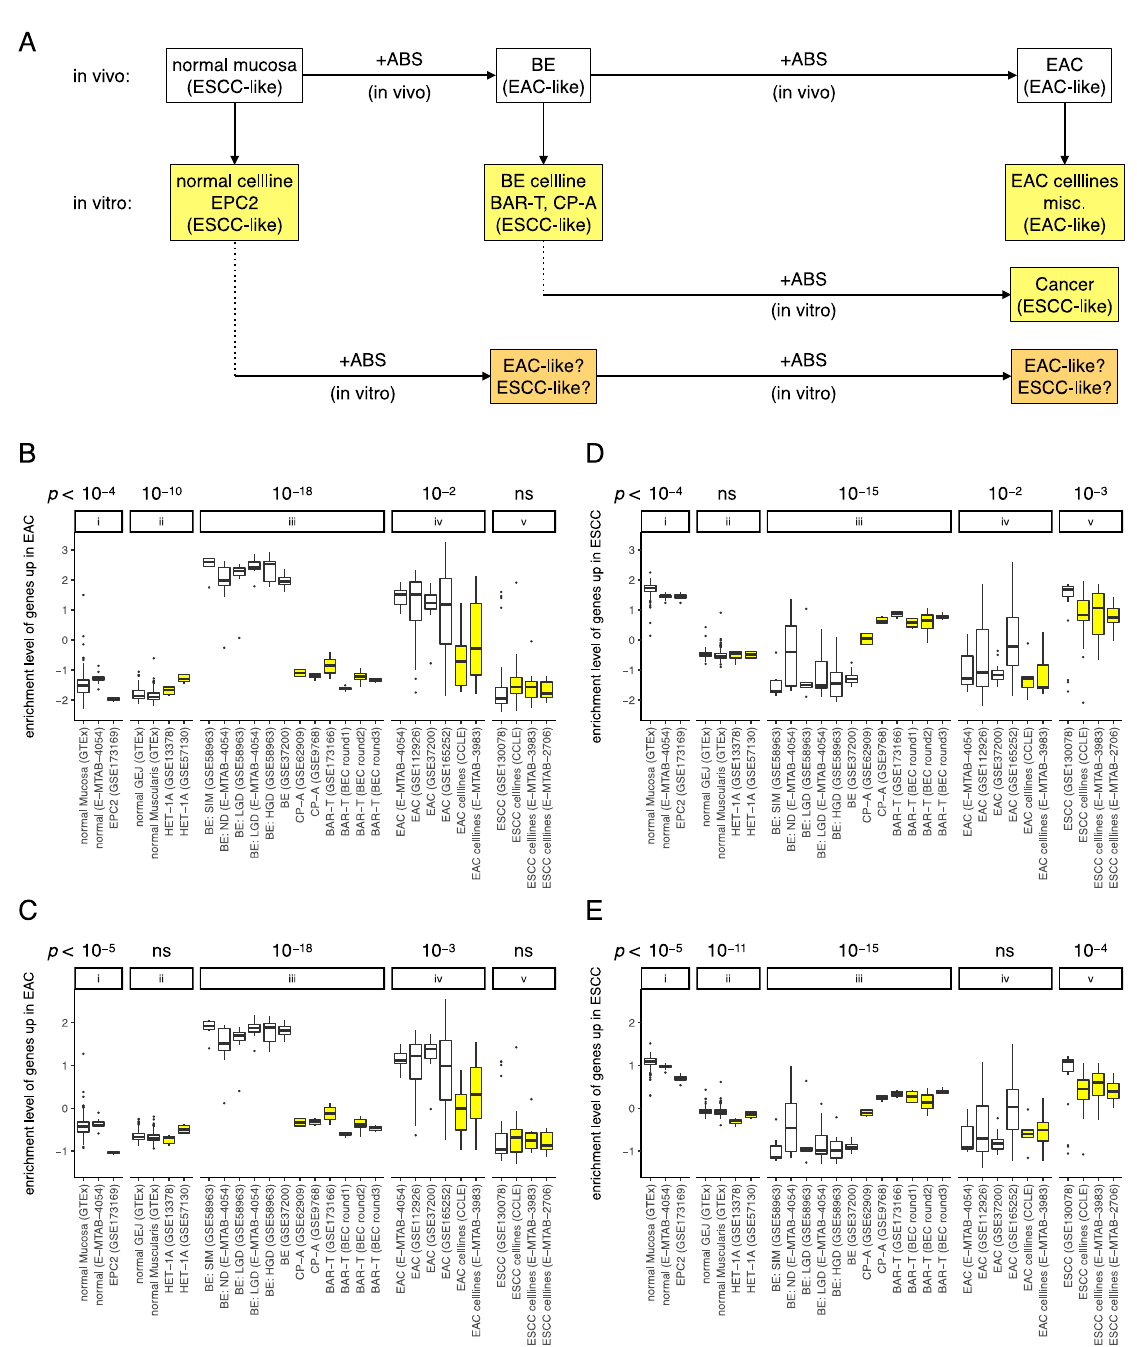
Figure 8. Summary of the main findings of this study. ( A ) Gatroesopahegal reflux is a known risk factor that changes ESCC-like normal mucosa to EAC-like primary BE tissue, after which it remains EAC-like as further ABS exposure changes it from primary BE tissue to primary EAC tumor. Cell lines made from ESCC-like normal mucosa remains ESCC-like and quite similar to normal mucosa. Cell lines made from the EAC-like primary BE tissue surprisingly becomes ESCC-like and extremely different from primary BE tissue. Cell lines made from primary EAC tumor remains EAC-like but becomes considerably different from primary EAC tumor. Unlike cell lines made from primary EAC tumor which are at least EAC-like, malignantly transformed BE cell lines (due to in vitro ABS exposure) are surprisingly ESCC-like. It will be interesting to see whether in vitro ABS exposure changes the transcriptome of the normal cell line EPC2 from ESCC-like to EAC-like. Enrichment levels of ( B ) 100 EAC hi genes, ( C ) 500 EAC hi genes, ( D ) 100 ESCC hi genes, and ( E ) 500 ESCC hi genes in tissues (white) vs. cell lines (yellow): (i) normal esophagus mucosa and squamous esophagus vs. the normal cell line EPC2, (ii) normal esophagus muscularis and gastro–esophageal junction